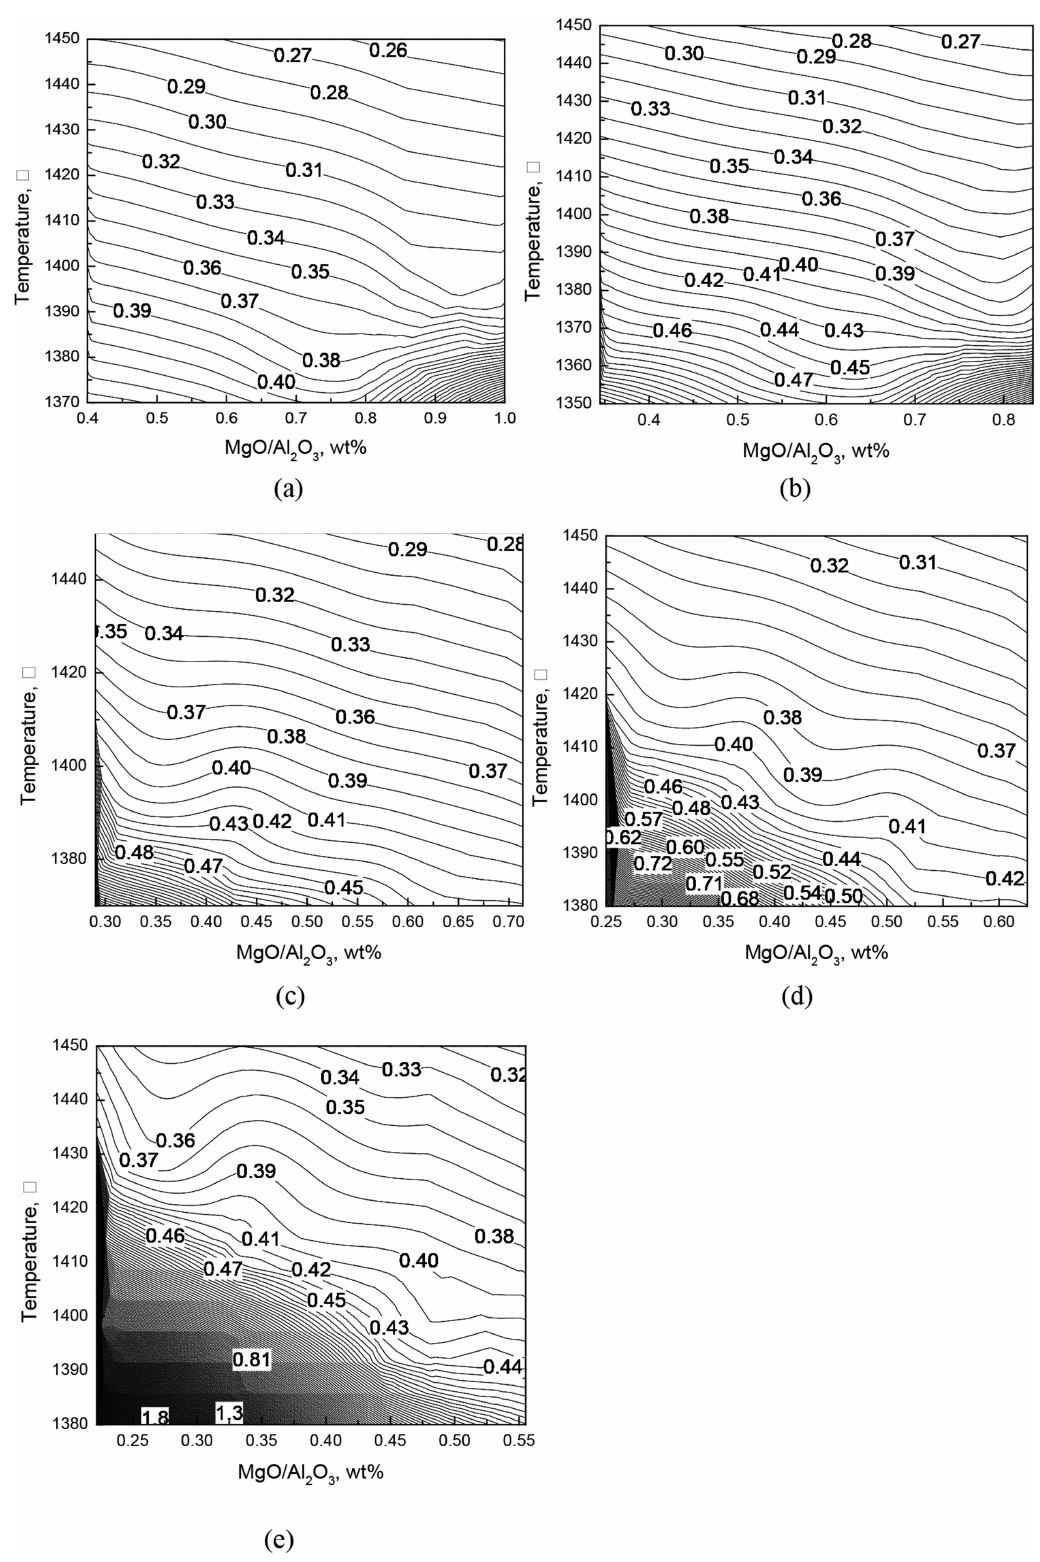
Figure 5: Influence of MgO/Al 2 O 3 ratio and temperature on viscosity for different Al 2 O 3 . (a)10 wt%, (b)12 wt%, (c)14 wt%, (d)16 wt% and (e)18